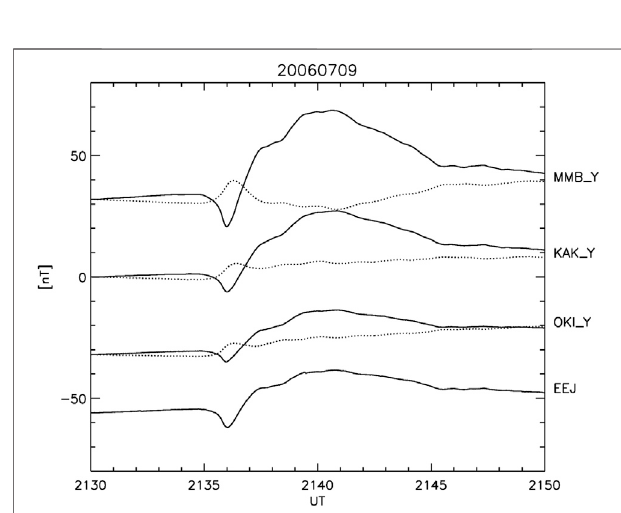
Frontiers in Astronomy and Space Sciences |